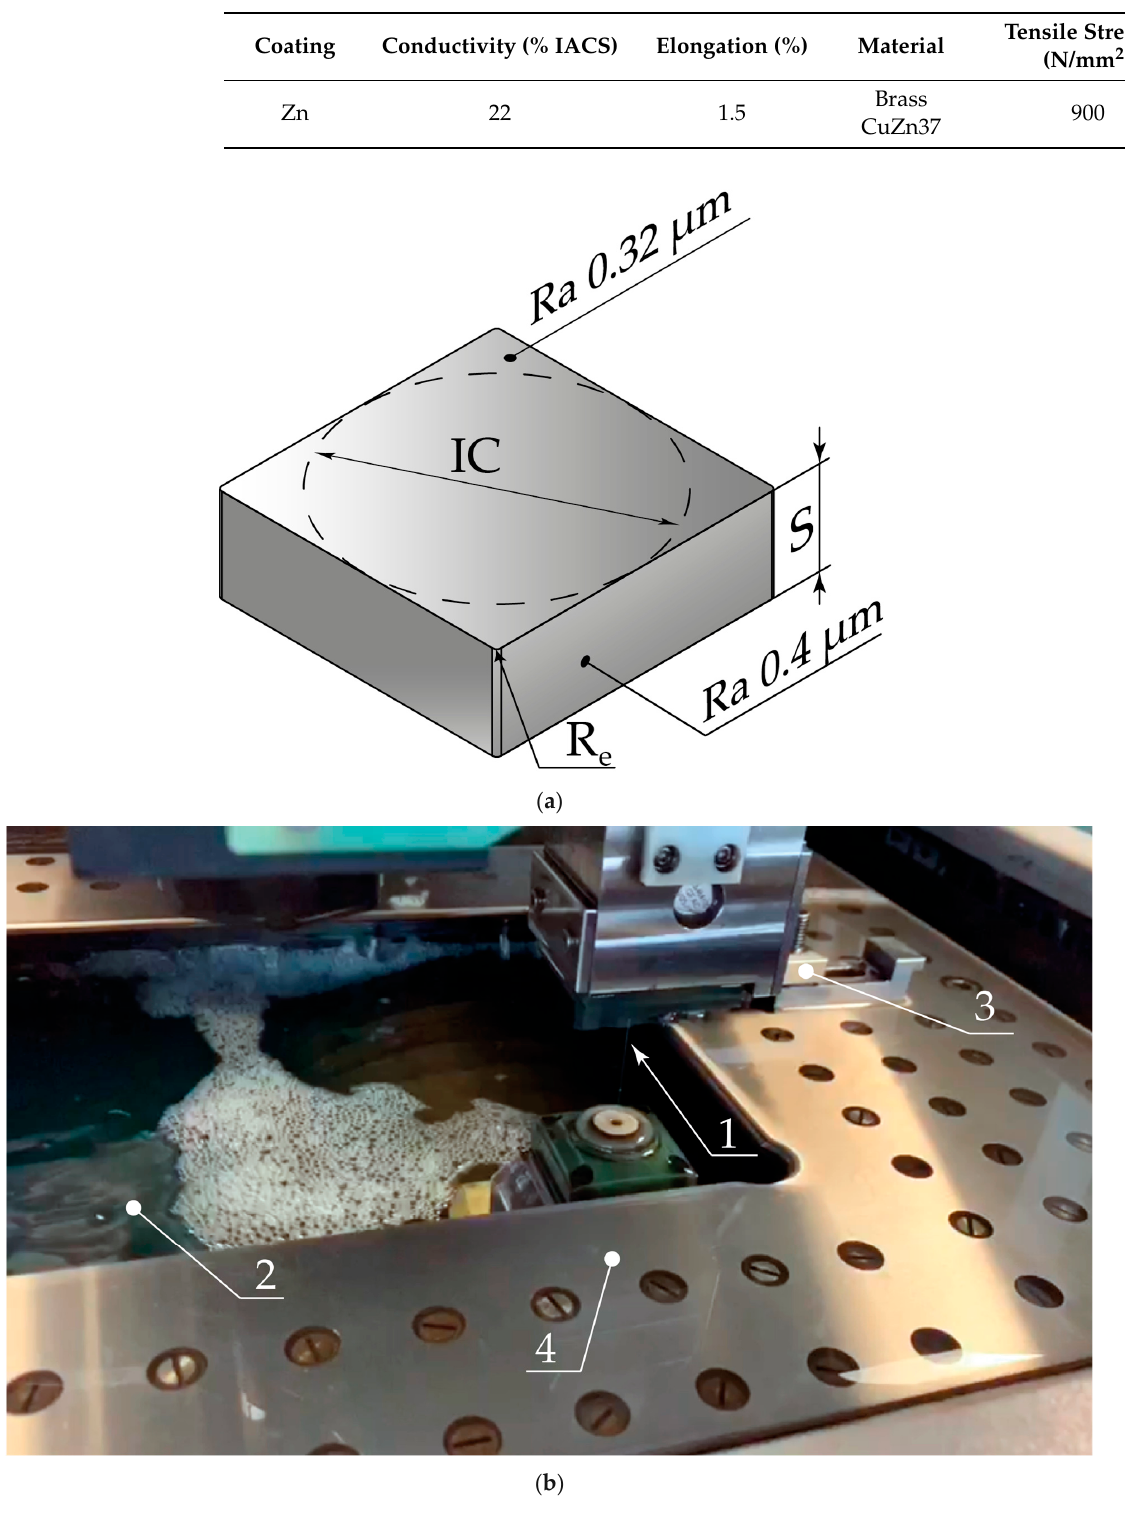
Figure 1. ( a ) Cutting insert, its geometry and requirements for Ra. ( b ) Working zone of the Agie Charmilles CUT 1000 OilTech machine: 1—wire; 2—dielectric oil; 3—device for clamping the workpiece; 4—table.